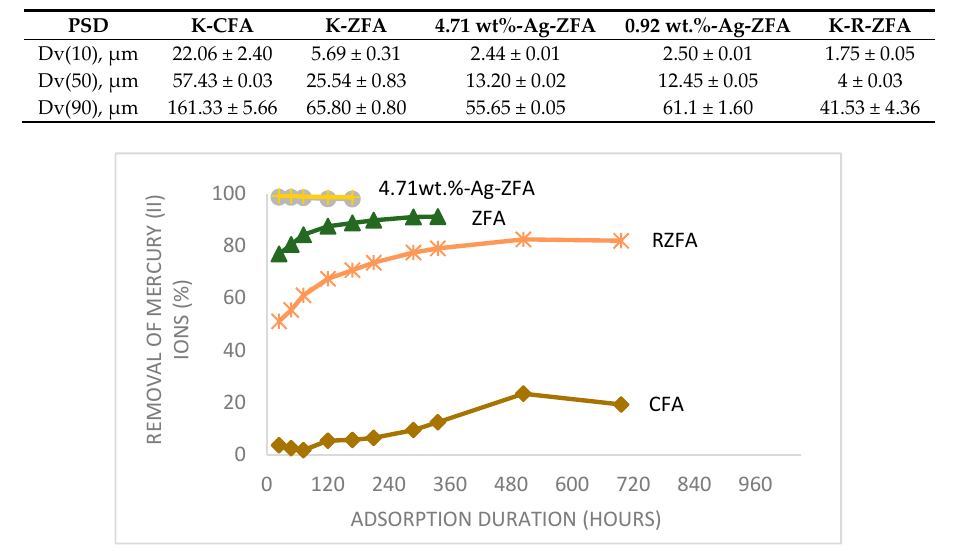
Figure 2. Adsorption kinetics of Hg 2+ from aqueous